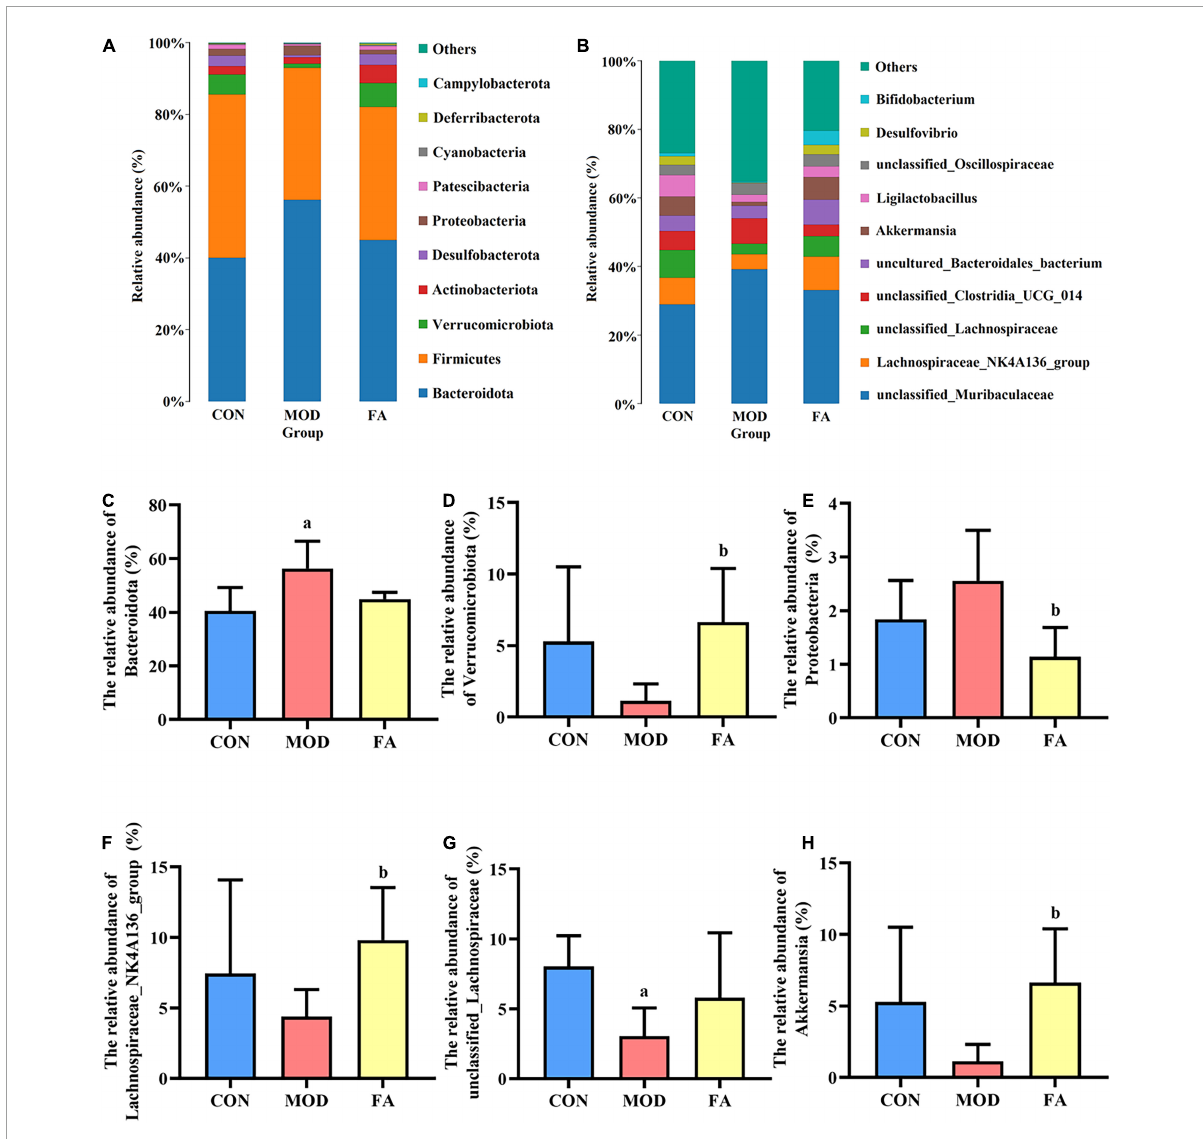
FIGURE6 Effects of folic acid on gut microbiota composition at phylum and genus levels. (A,B) Composition of gut microbiota at phylum and genus levels; (C) relative abundance of Bacteroidota ; (D) relative abundance of Verrucomicrobiota ; (E) relative abundance of Proteobacteria ; (F) relative abundance of Lachnospiraceae_NK4A136_group ; (G) relative abundance of unclassified_Lachnospiraceae ; (H) relative abundance of Akkermansia . Data are presented as mean ± SD ( n = 5/group). a p < 0.05 compared with the CON group; b p < 0.05 compared with the MOD